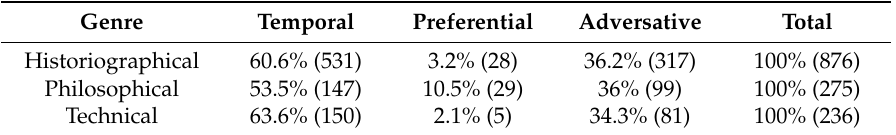
Table 4. Frequencies of temporal, preferential and adversative meaning per text genre.